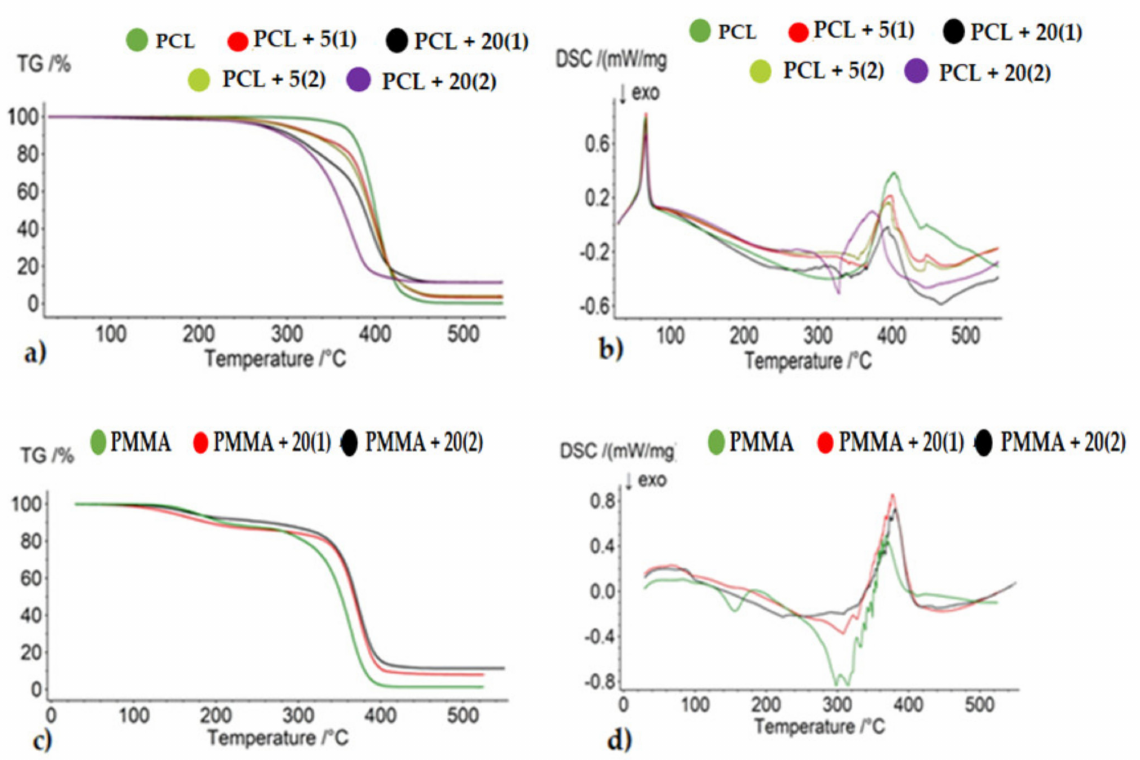
Figure 5. Thermogravimetric curves (TGA) ( a , c ) and the differential scanning calorimetry curves of (DSC) ( b , d ) of the produced composite